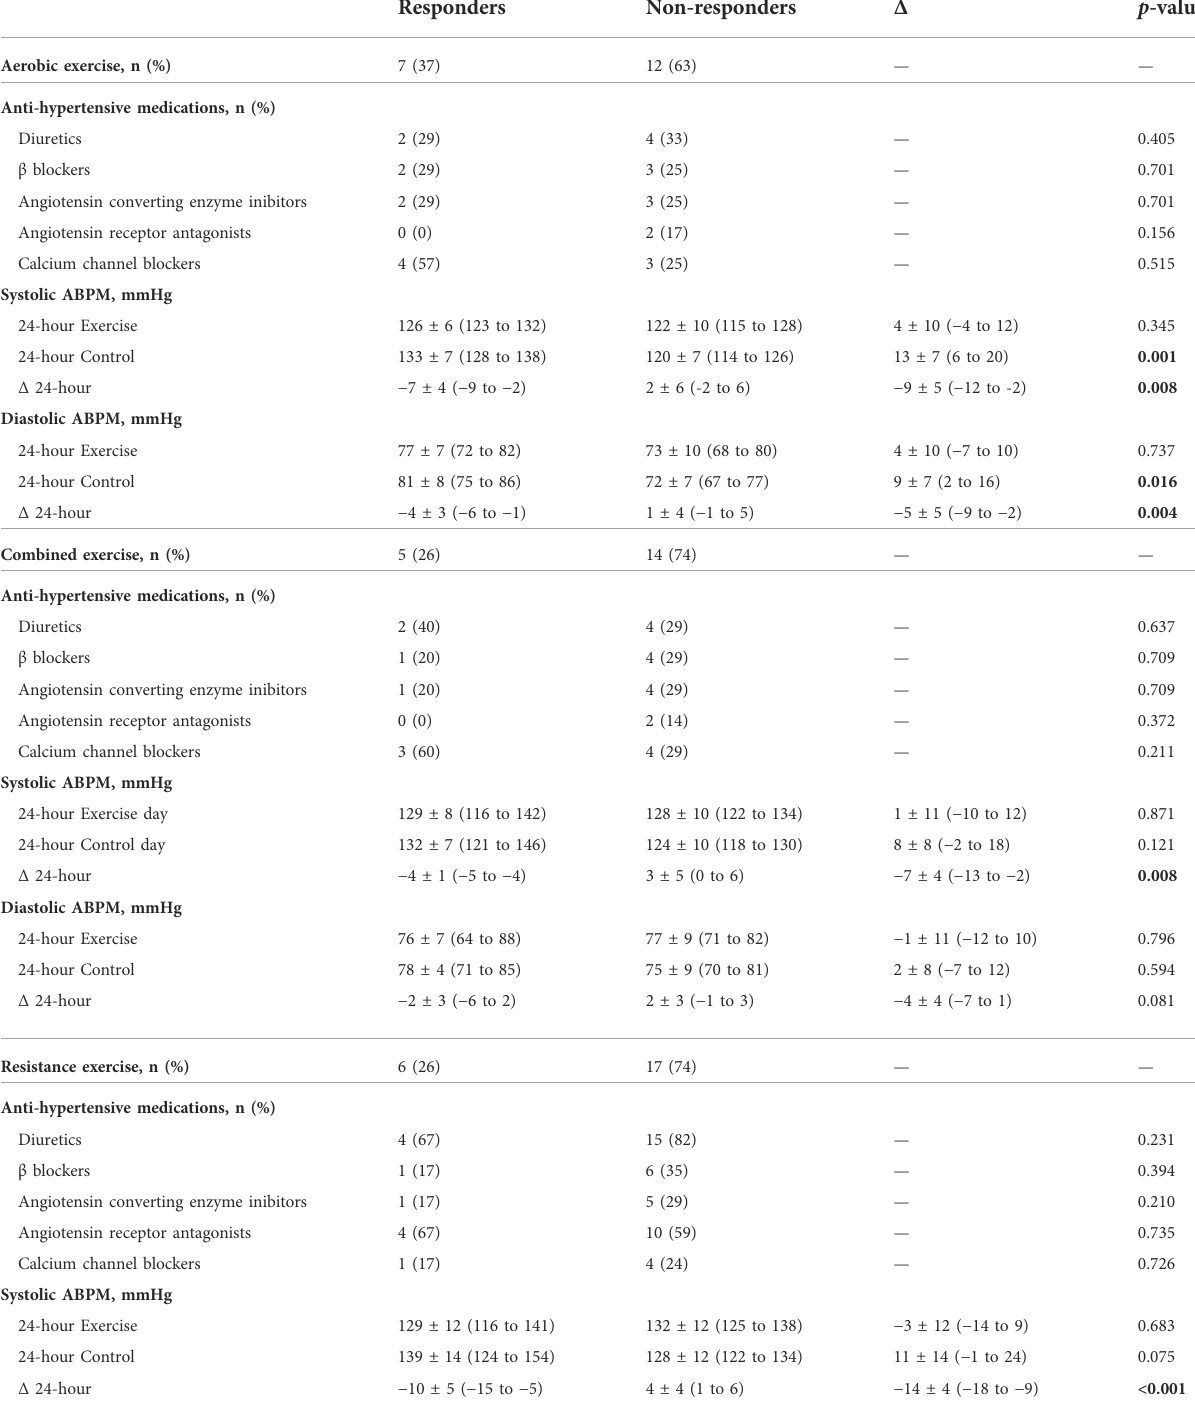
TABLE 3 Differences in characteristics between responders and non-responders for 24-h systolic BP in each exercise modality. Responders Non-responders Δ p